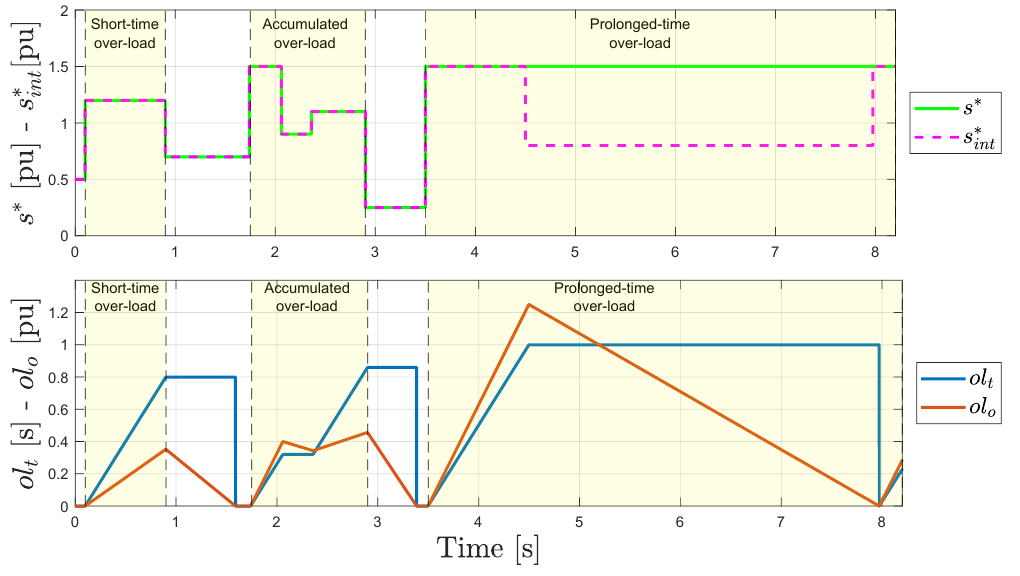
Figure 11. Example of the power over-load supervisor algorithm